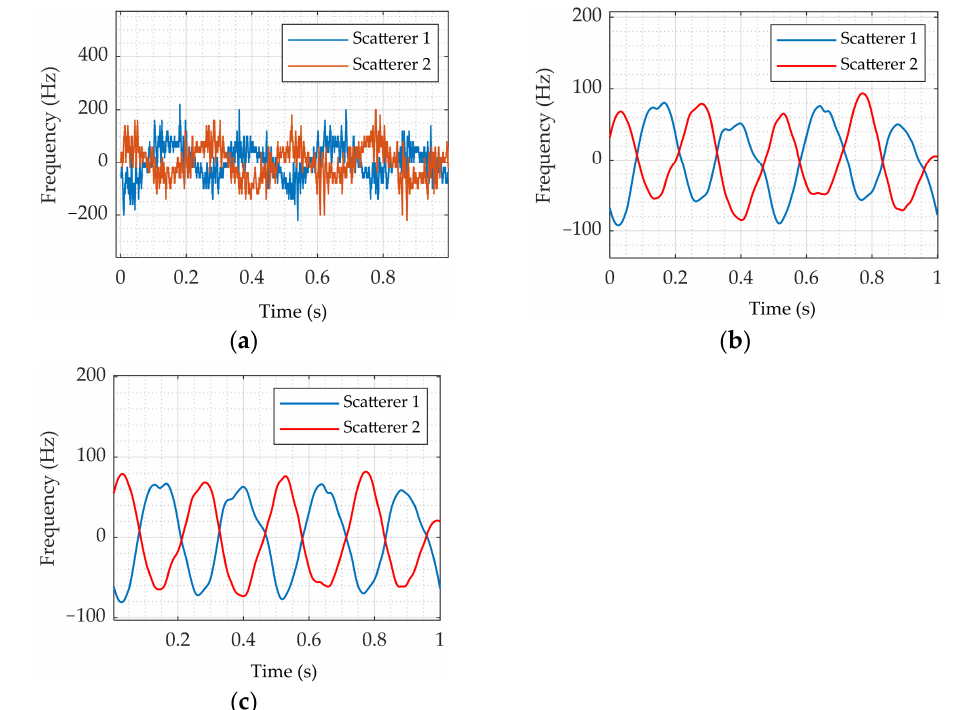
Figure 11. The micro-Doppler effect of the proposed method when the SNR is − 5 dB. The results after the interference processing in time-frequency domain ( a ); The results after curves’ smoothing (b); The micro-Doppler curves after filtering ( c ).